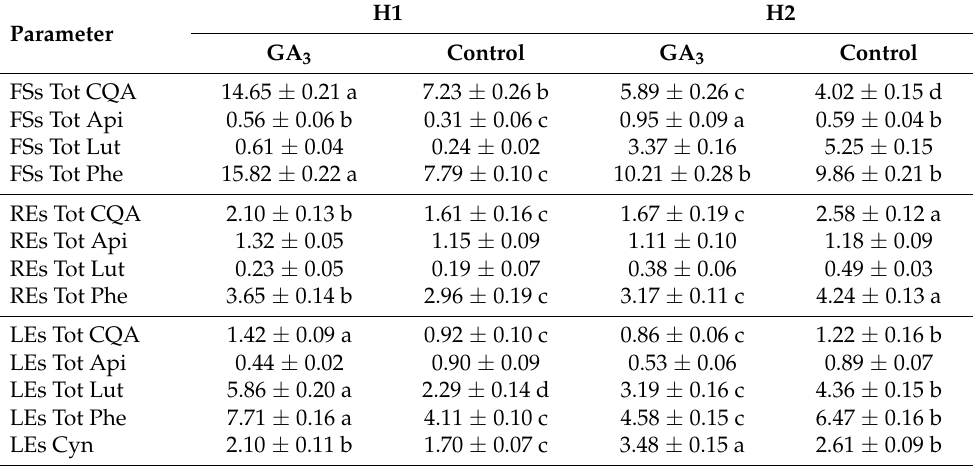
Table 2. Content (g kg − 1 of D.M.) of total caffeoylquinic acid (Tot CQA), total apigenin (Tot Api), total luteolin (Tot Lut), total measured polyphenol (Tot Phe), and cynaropicrin (Cyn) in the floral stems (FSs), receptacles (REs), and leaves (LEs) of the globe artichokes as affected by the ‘GA 3 treatment × harvest time’ interaction. Different letters within the same row show significant differ- ences among means ± s.d. (LSD test, p <